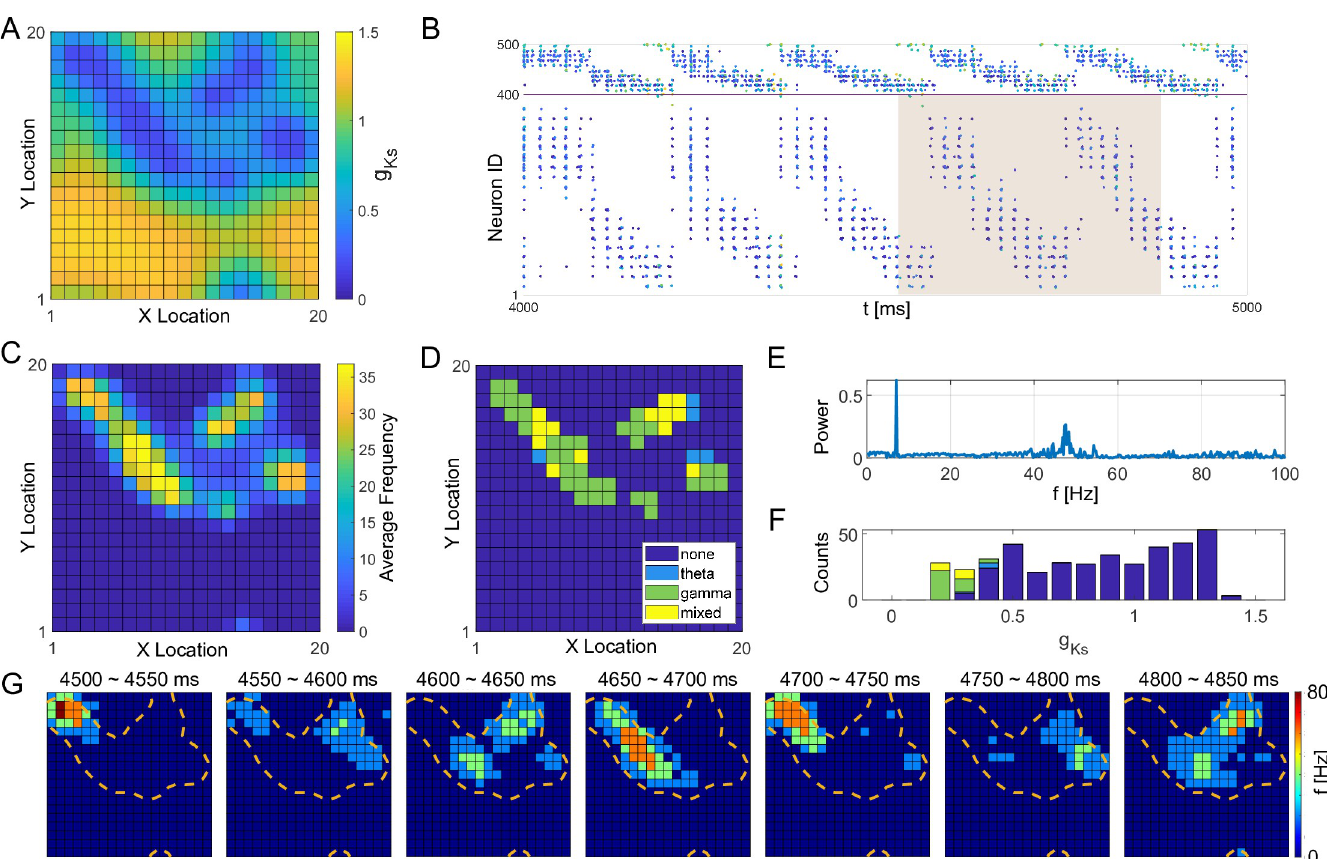
Fig 2. Theta and gamma band activity generated by a spatially heterogeneous g distribution. A, Randomly generated spatial map of g values on the 20 × 20 E cell K s K s value (same color scale as lattice. B, Spike raster plot illustrating portion of E cell (cells 1 − 400) and I cell (cells 401 − 500) firing patterns. The pixel color indicates cell g K s in A). The shaded area indicates the time range of snapshots in F. C, Average E cell firing frequencies plotted as cell position on the E cell lattice showing highest firing within the regions or ’hotspots’ of low g . D, Dominant rhythmic activity of individual E cells (dark blue = none, light blue = theta band, green = gamma band and K s yellow = mixed, both gamma and theta) displayed on E cell lattice illustrating that E cells with lower g values showed stronger and more stable gamma activity while K s cells with moderate g values exhibited stronger theta rhythm. E, Power spectrum analysis of E cell network firing. High power exhibited in both theta (5-12Hz) and K s gamma (40-60Hz) rhythm bands. F, Distribution of g values for cells showing specific rhythmic activity illustrating correlation of activity type with g value (same K s Ks color code as in D). G , Snapshots of E cell firing rates from 4500–4850 ms during the simulation shown in B (shaded area). Cells inside the orange contour lines have g K s values less than 0.6 mS/cm 2